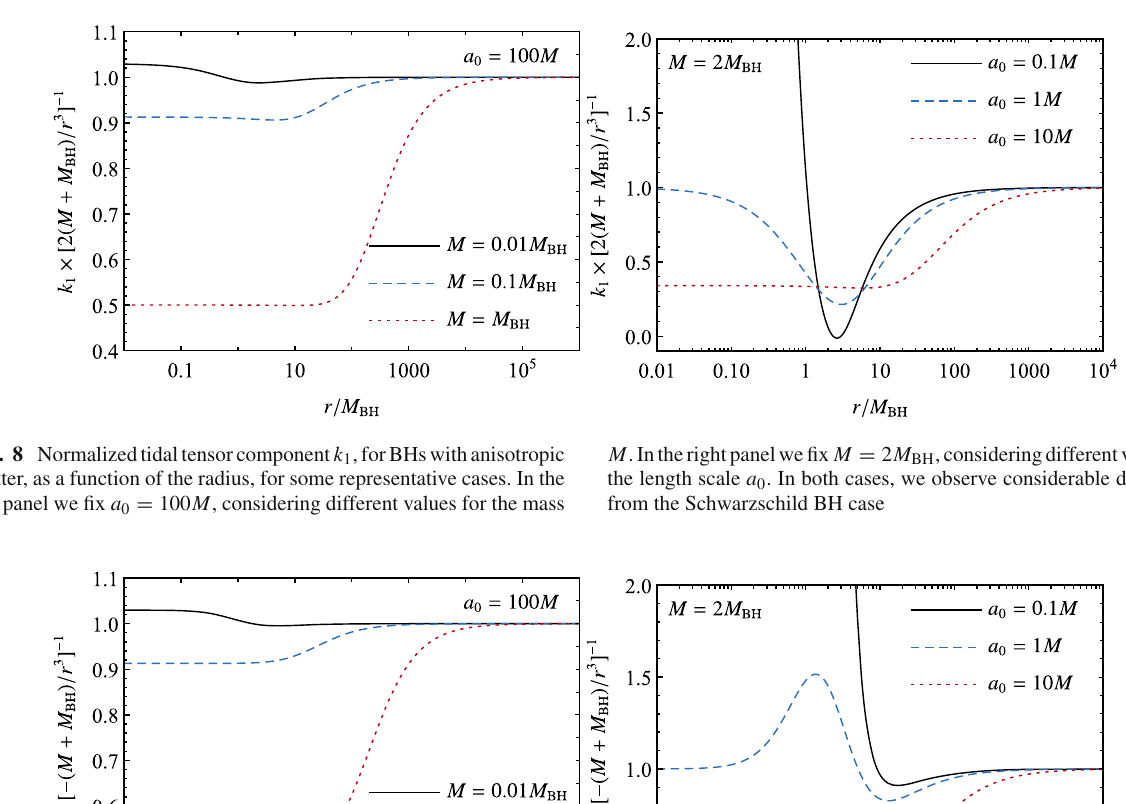
addition, E = 1. We see that the deviation from Schwarzschild case is considerable. For a fixed value of a 0 (left panel) the modifications are similar to the ones observed in Fig.